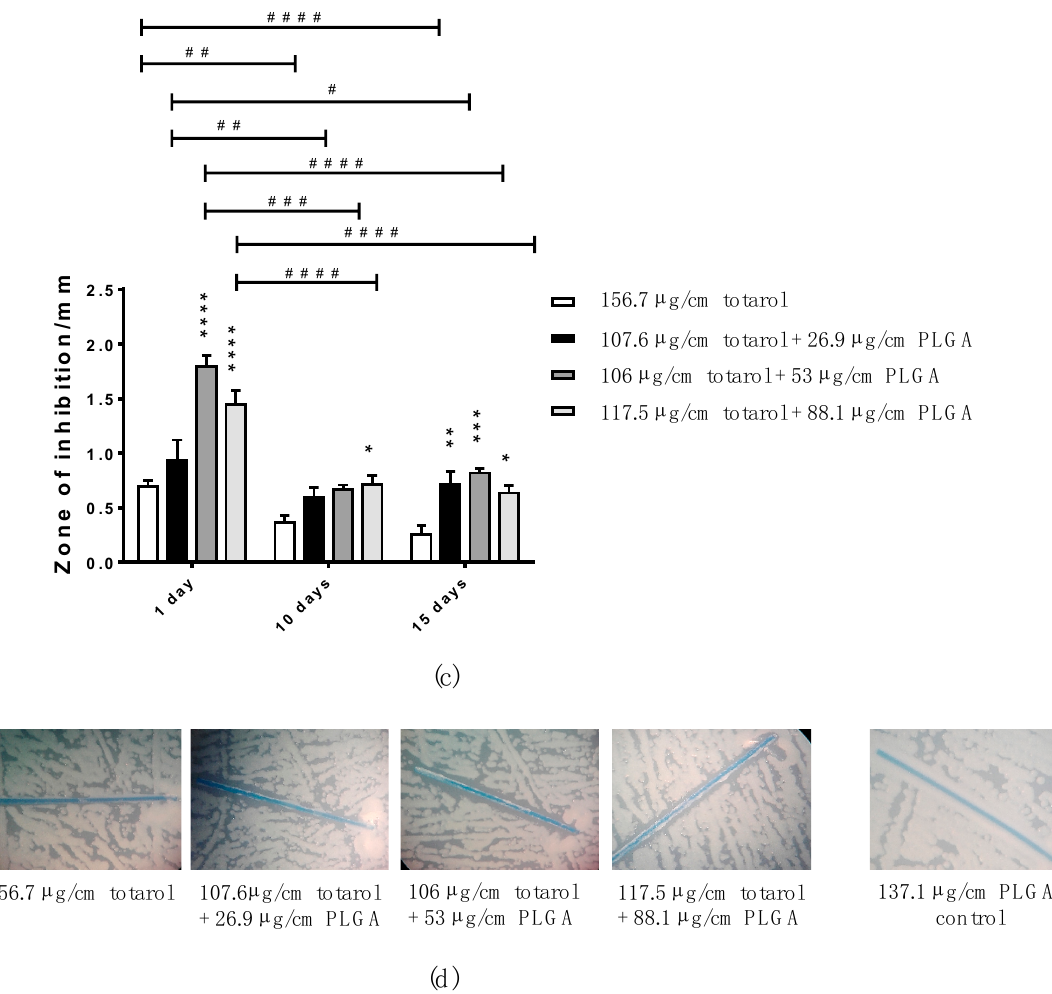
Figure 4. ( a ) Bar graph showing the differences in the zones of inhibition, arising during the Agar Diffusion Test (ADT), of monofilament sutures coated with a 25 mg/mL totarol stock solution and different concentrations of PLGA at days 1, 10 and 15 ( n = 3); ( b ) Representative images demonstrating a similar zone of inhibition after 15 days in all four groups. As the negative control, a PLGA-only-coated suture is shown; ( c ) Bar graph depicting the change in zones of inhibition around monofilament sutures sprayed with a coating solution with a concentration of 100 mg/mL totarol and varying amounts of PLGA at days 1, 10 and 15 of the ADT ( n = 3); ( d ) Representative images of the zones of inhibition of sutures coated in the four stock solutions at day 15. As the negative control, a PLGA-only-coated suture is shown. Data are given as means with SEM. Two-way RM ANOVA followed by Tukey’s multiple comparisons test was used to identify significant differences. Asterisks (* p < 0.05, ** p < 0.01, *** p < 0.001, and **** p < 0.0001) indicate statistical significances between the diverse coatings and the control (totarol coating without PLGA). Hashes ( # p < 0.05, ## p < 0.01, ### p < 0.001, and #### p < 0.0001) indicate statistical significance between the equal coating solutions at the various time points.